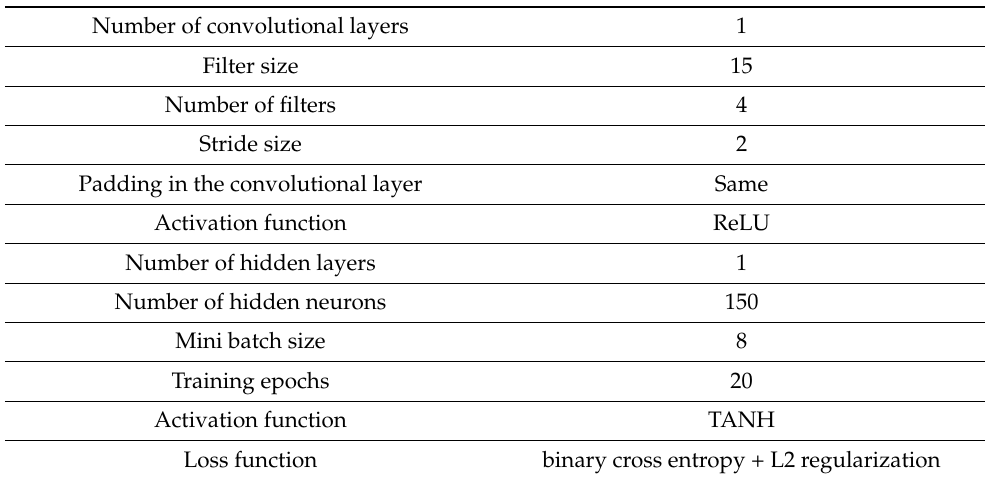
Table 3. Model configuration for the CNN with detailed parameters. Number of convolutional layers 1 Filter